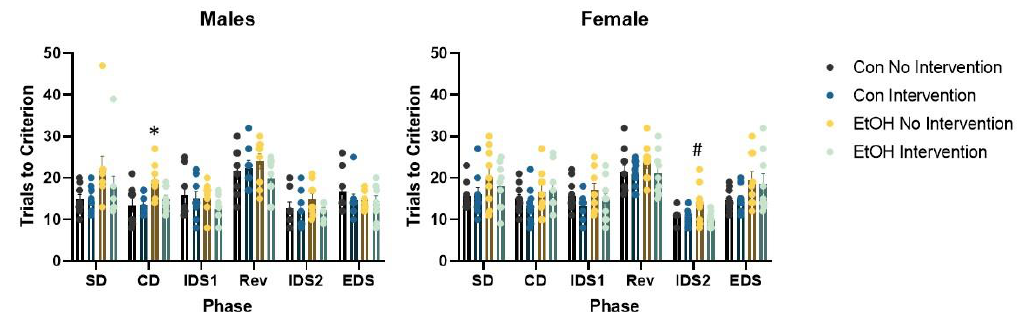
attentional set shifting task. Isolation of the shift cost confirmed a main effect of sex, F (1,64) = 10.78, exhibited an increase in the number of trials required to solve the extradimensional shift, while males exposed to EtOH were less likely to increase the number of trials necessary for eight correct consecutive responses relative to the immediately preceding intradimensional shift.